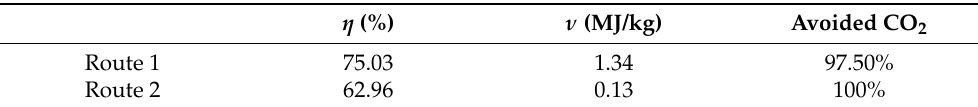
Table 9. Comparison between the Route 1 and Route 2 CO 2 -treating